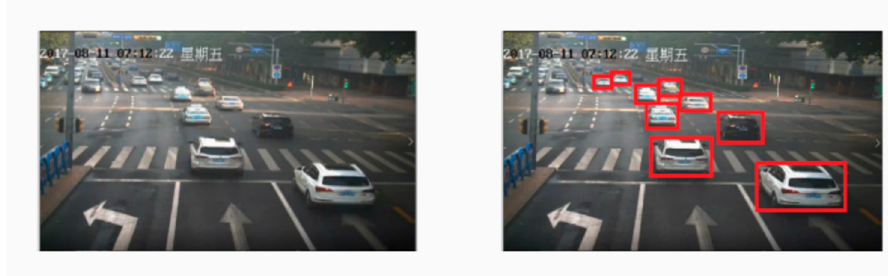
Figure 2. ROI image acquisition.